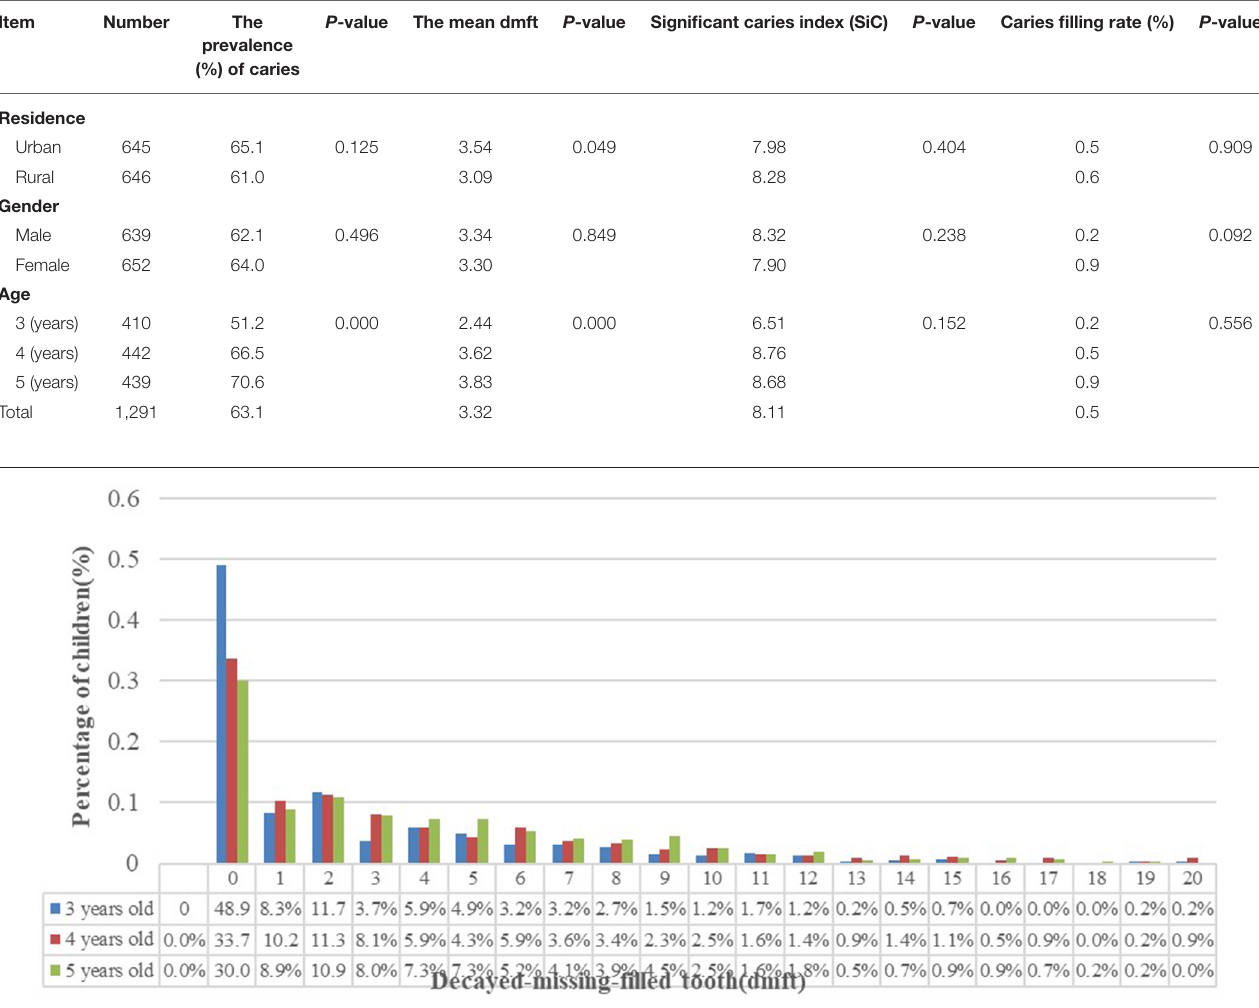
TABLE 1 | Dental caries status of 3- to 5-year-old children in Guizhou Province. Item